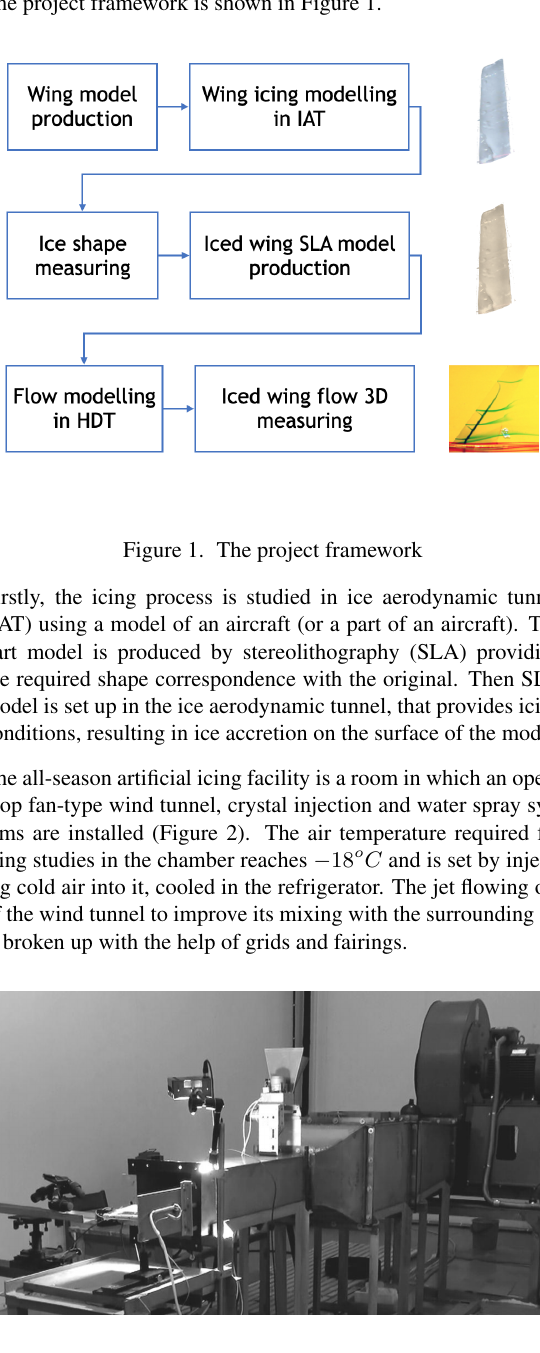
Figure 2. Icing wind